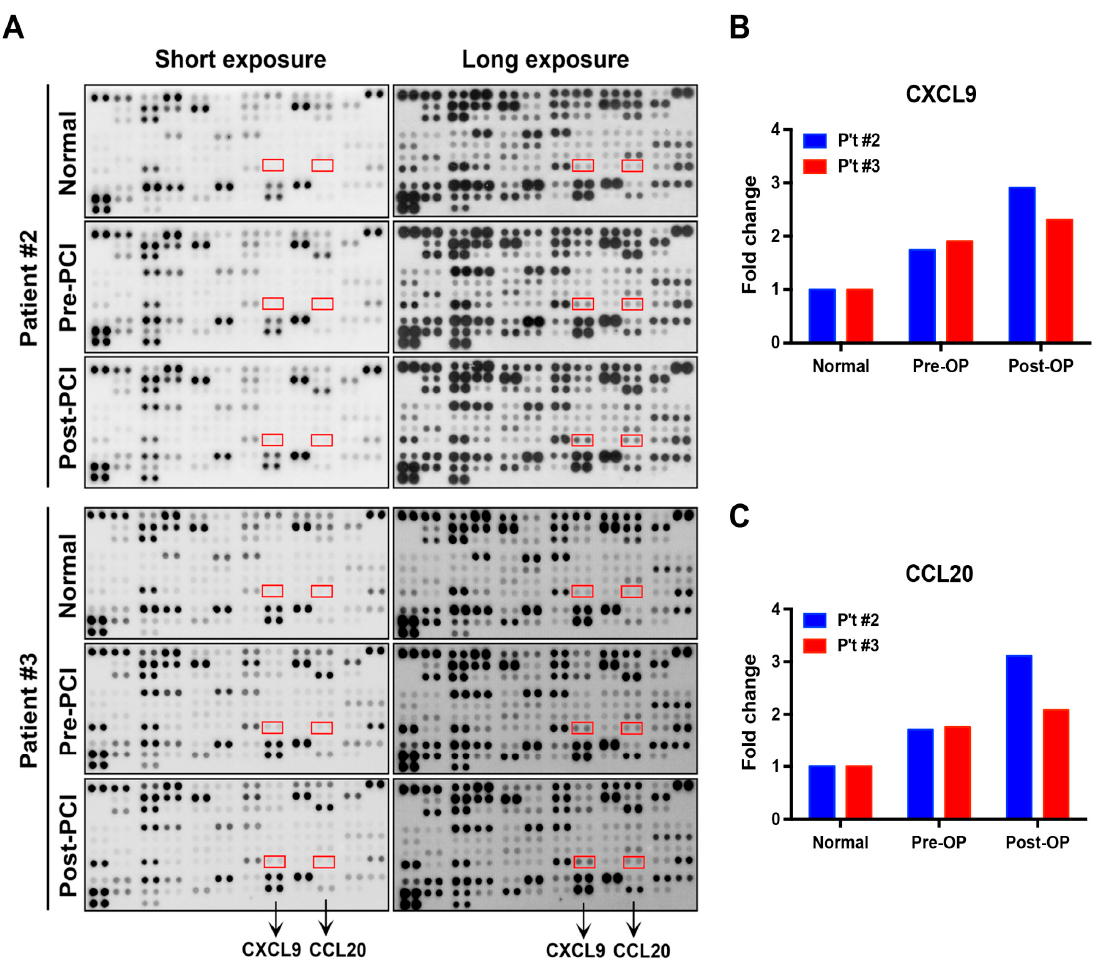
Figure 1. Protein array analysis evaluating the expression of CXCL9 and CCL20 among various detected protein in patients with MI (patient #2 and #3) and normal subjects (healthy volunteers in our laboratory). ( A ) The expression of CXCL9 and CCL20 consistently increased in samples of short- and long-term exposures. ( B ) Fold change of CXCL9 expression in patient #2 and #3. ( C ) Fold change of CCL20 expression in patient #2 and #3. MI = myocardial infarction; PCI = percutaneous coronary intervention; Post-PCI = 3 h after coronary reperfusion by PCI; Pre-PCI = before PCI.